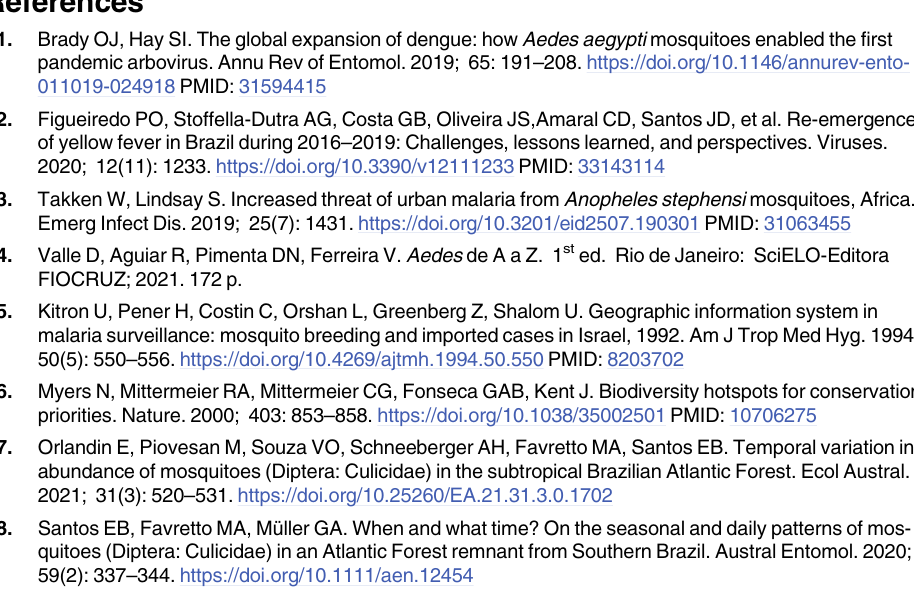
S1 Fig. Photograph of the four types of breeding sites sampled at the Poc¸o das Antas Bio- logical Reserve in southeastern Brazil. A and B: lake; C: bromeliad; D: puddle; E and F: bam- boo. (TIF) S1 Table. Data from the mosquito collections carried out at the Poc¸o das Antas Biological Reserve in southeastern